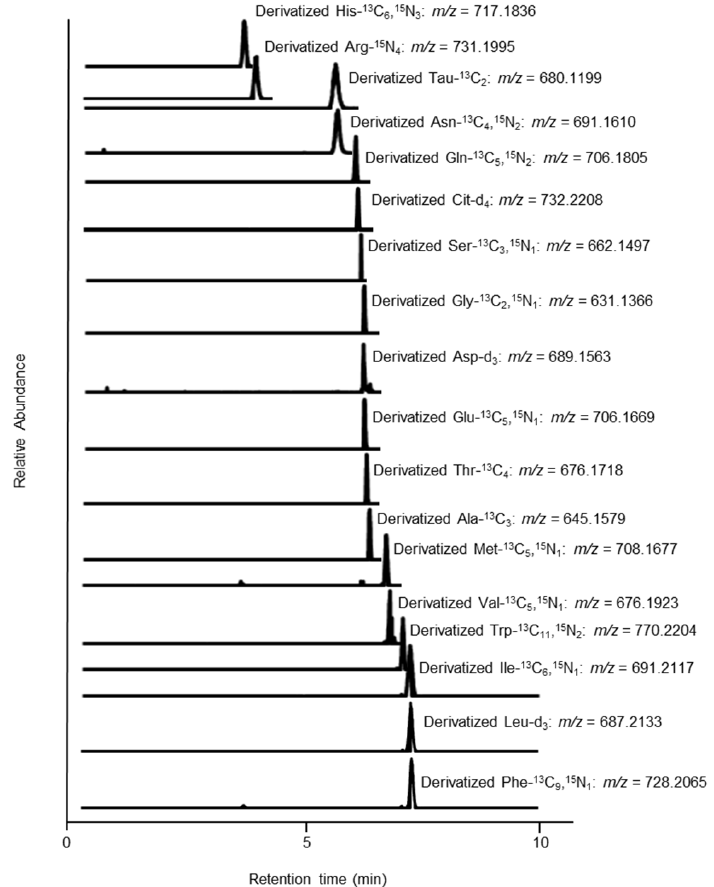
Figure 6. SIM chromatogram showing 18 stable isotope-labeled amino acid derivatives.